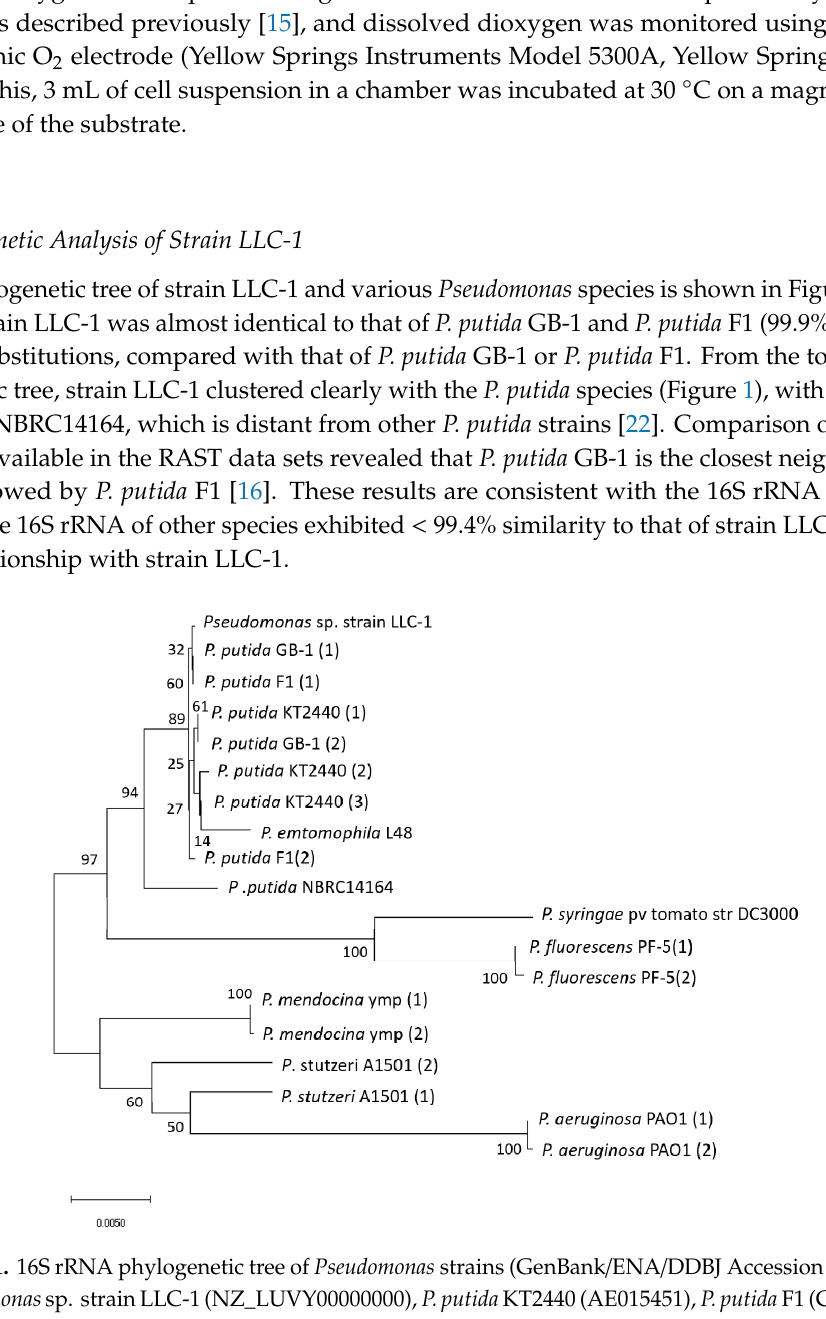
Figure 1. 16S rRNA phylogenetic tree of Pseudomonas strains (GenBank/ENA/DDBJ Accession